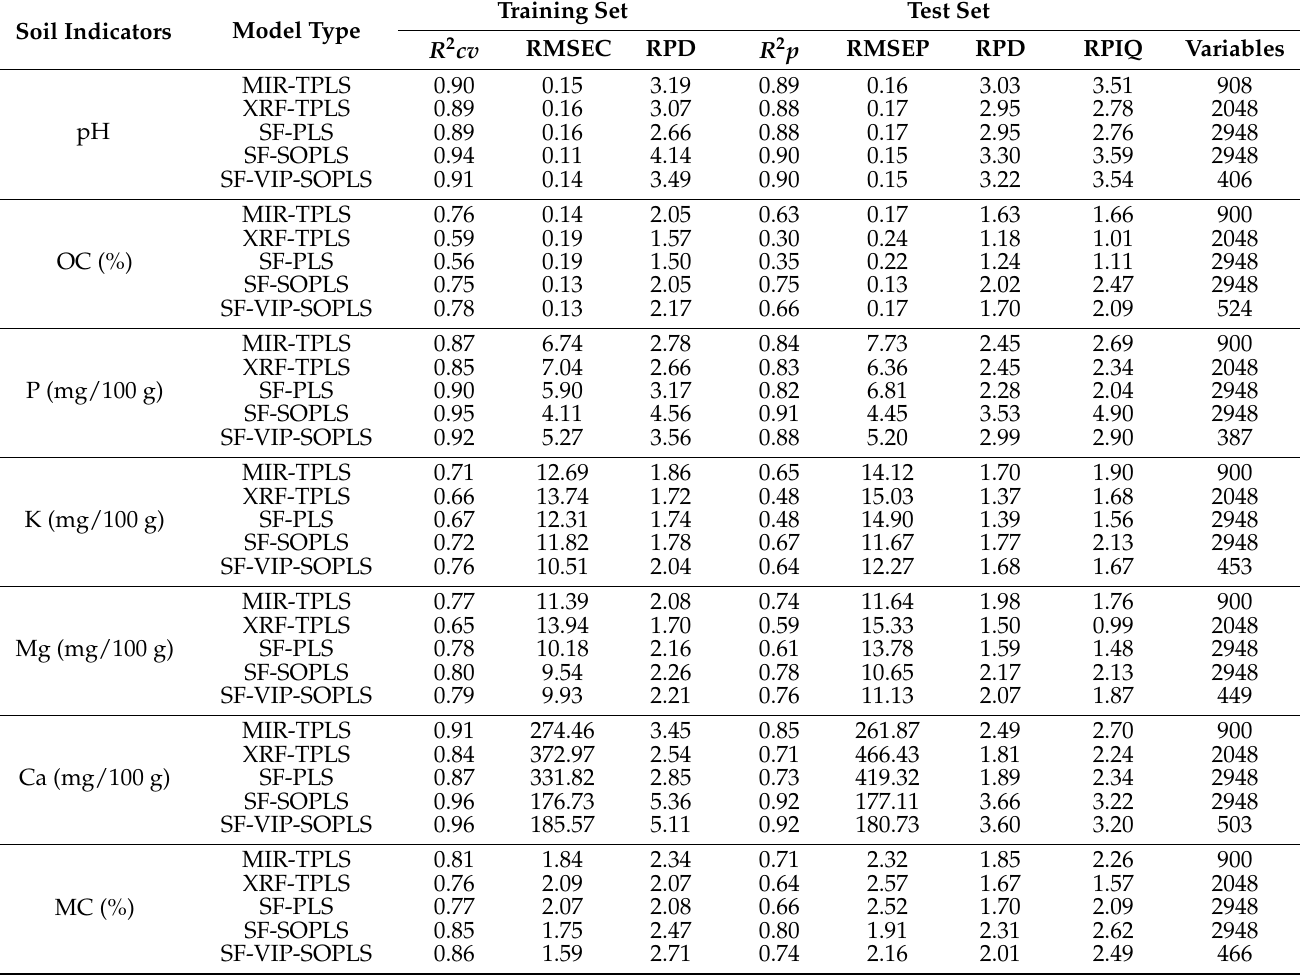
Table 4. Prediction results of soil pH, organic carbon (OC), phosphorous (P), potassium (K), magne- sium (Mg), calcium (Ca), moisture content (MC) using traditional PLS model (TPLS), and spectra- fusion (SF-PLS, SF-VIP-SOPLS and